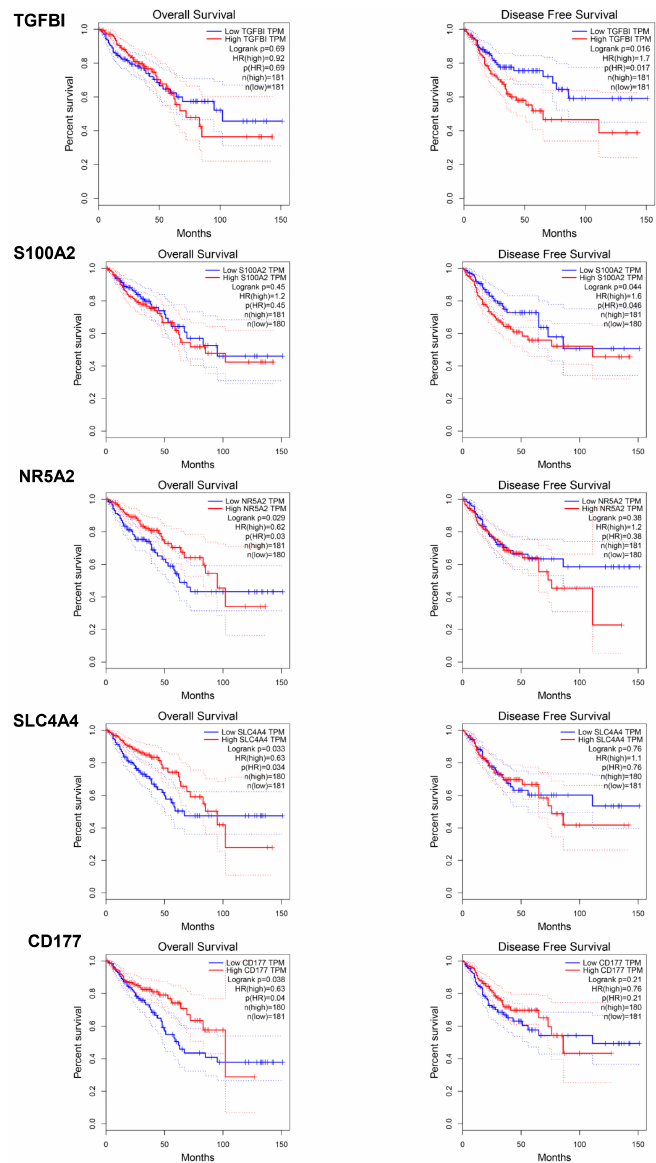
Figure 5. Overall survival and disease-free survival analysis of TGFBI , S100A2 , NR5A2 , SLC4A4 , and